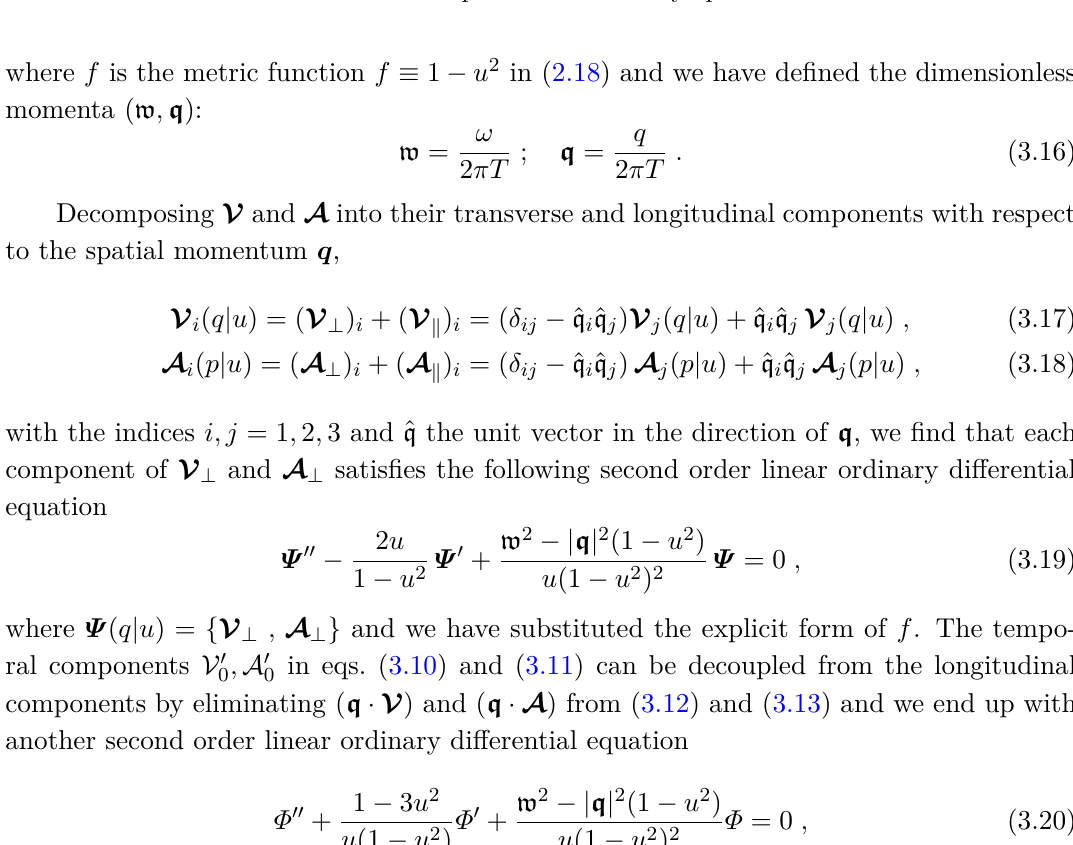
Table 1 . ∆ Indexes of power series and asymptotic